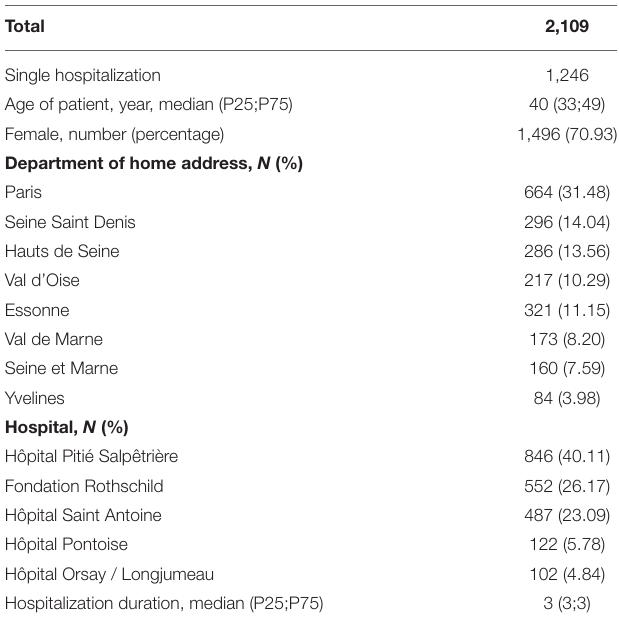
TABLE 1 | Description and characteristics of included multiple sclerosis (MS)